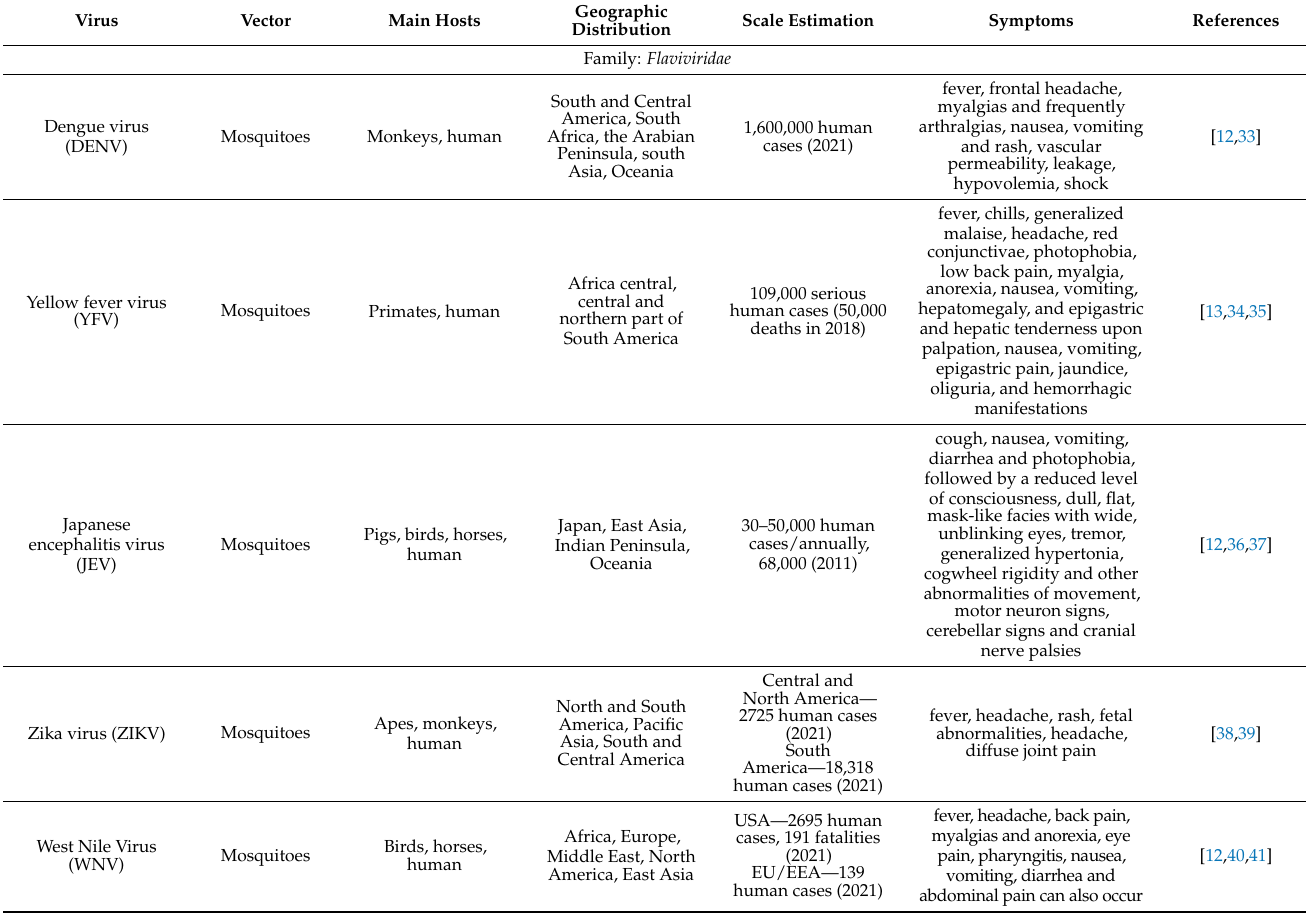
Table 1. Characteristic of selected